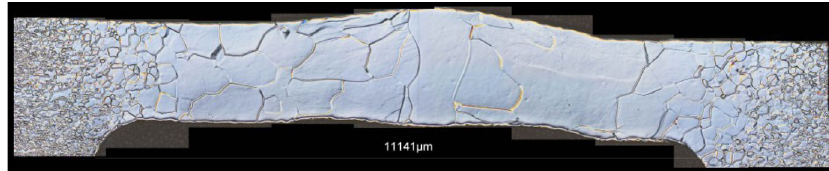
FIG. 22. Microstructure of the electron beam weld of high purity niobium. The grain size scope is 50 – 2000 μ